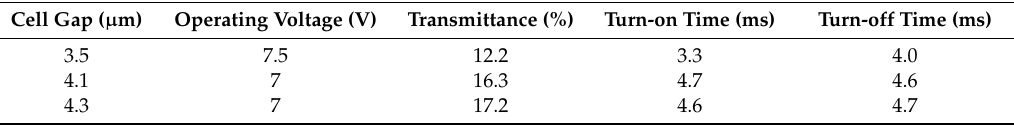
Table 2. Dependence of the measured electro-optical characteristics of IPS cells, fabricated by curing 1 wt% of RM at − 20 °C, on the cell gap.